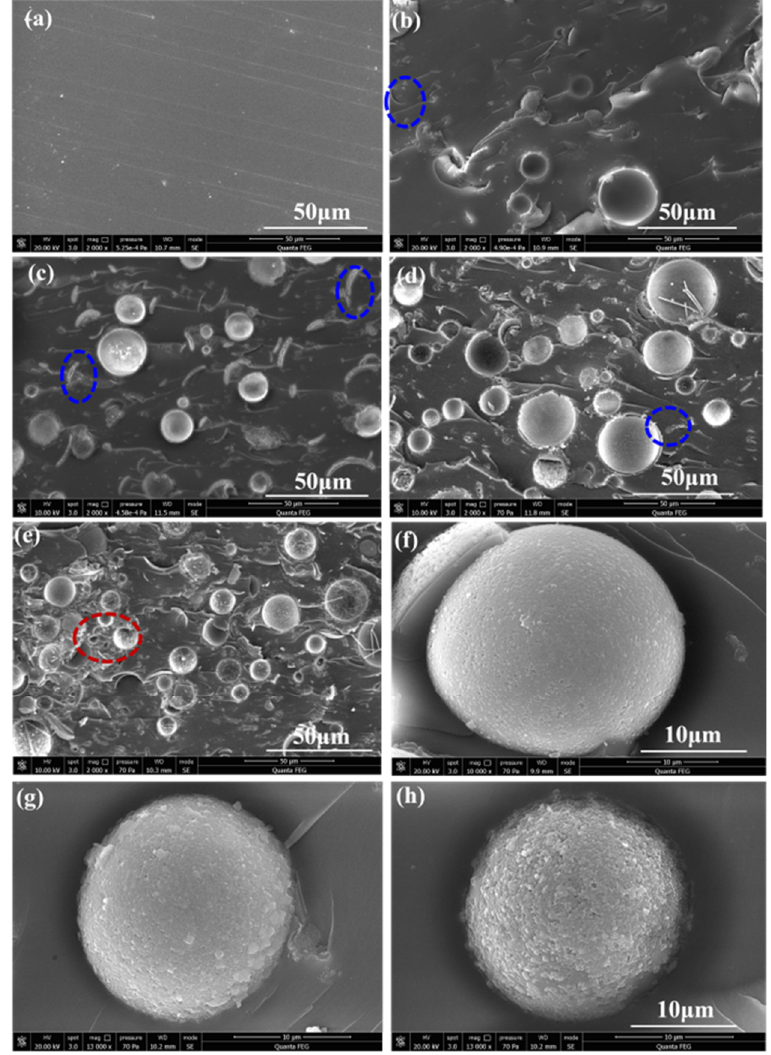
Figure 4. SEM images of the PBDP phthalonitrile resin and composites fracture surface: ( a ) PBDP phthalonitrile resin, ( b ) PBDP/10.2HGM-NH 2 , ( c ) PBDP/19.3HGM-NH 2 , ( d ) PBDP/27.5HGM-NH 2 , ( e ) PBDP/35.0HGM-NH 2 , ( f ) PBDP/19.2HGM-NH 2 , ( g ) PBDP/27.5HGM-NH 2 , ( h ) PBDP/37.5HGM. (The blue circle indicates broken HGM-NH 2 particles, and the red circle indicates slight agglomera- tion